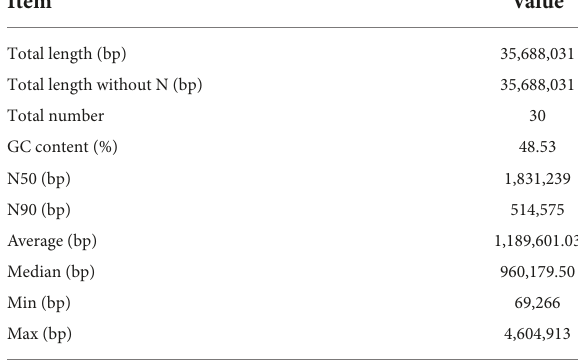
TABLE 2 Statistics of the assembly